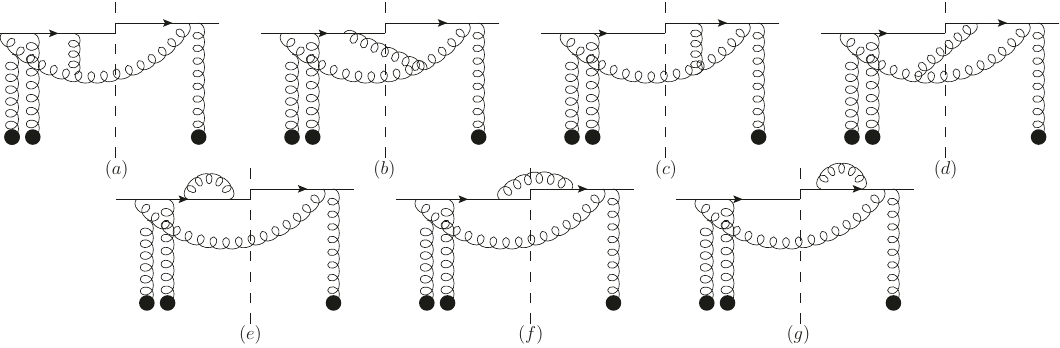
Figure 4 . Sample diagrams contributing to the BK kernel at two loop order. The contributions from the (cid:12)gures 4a+4b are completely canceled out up to the double leading logarithm accuracy. The same cancellation occurs between the (cid:12)gure 4c and the (cid:12)gure 4d. In contrast, the double leading logarithm NLO correction to the real part of the LO BK kernel arise from the incomplete cancellation among (cid:12)gure 4e, (cid:12)gure 4f and (cid:12)gure